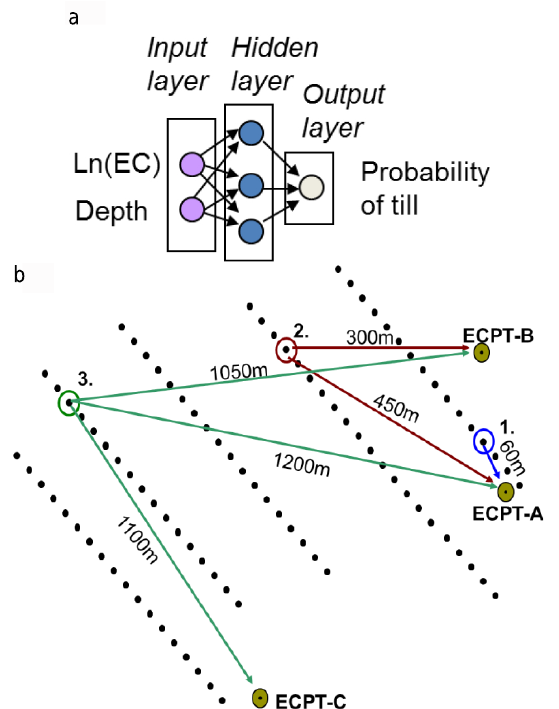
Fig. 14. (a) Neural Network architecture for determining till from Ln(EC) and depth. (b) Search strategy for determining relevant ECPTs for training ANN.